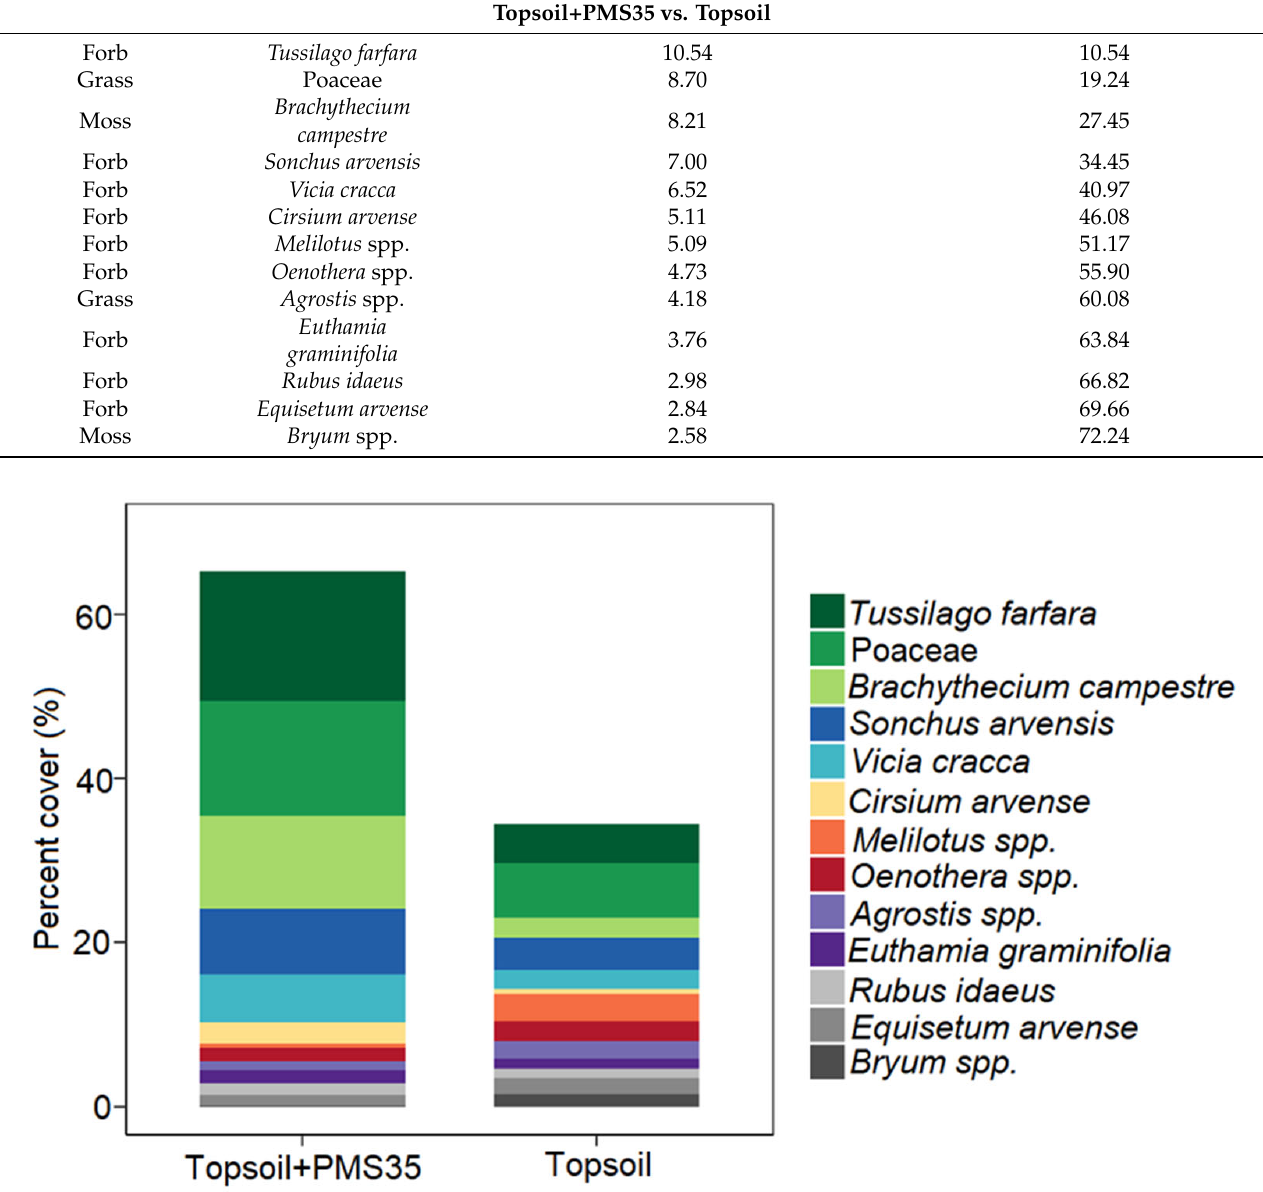
Figure 3. SIMPER analysis of percent cover of species having the greatest contribution to dissimilarity at the Niobec site between plots amended with both topsoil and PMS (topsoil+PMS35) and plots amended with topsoil only.